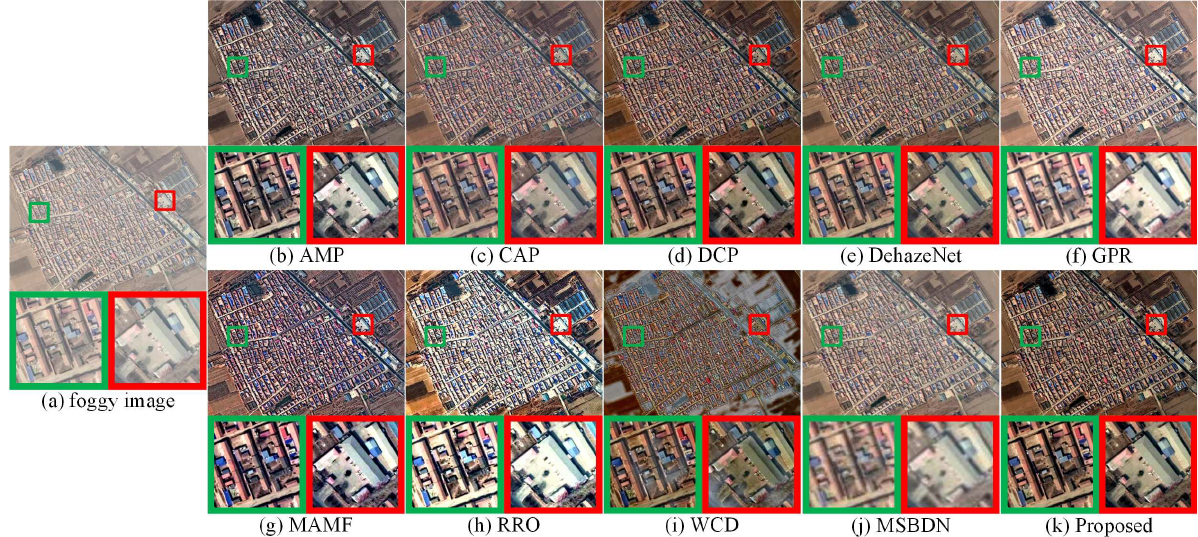
Figure 6. ( a ) shows a real-world foggy remote sensing image. ( b – k ) respectively represent the defogged images obtained by AMP, CAP, DCP, DehazeNet, GPR, MAMF, RRO, WCD, MSBDN, and the proposed method. The two partially enlarged images marked in the green and red frames correspond to two areas enclosed by the green and red frames in each defogged image.